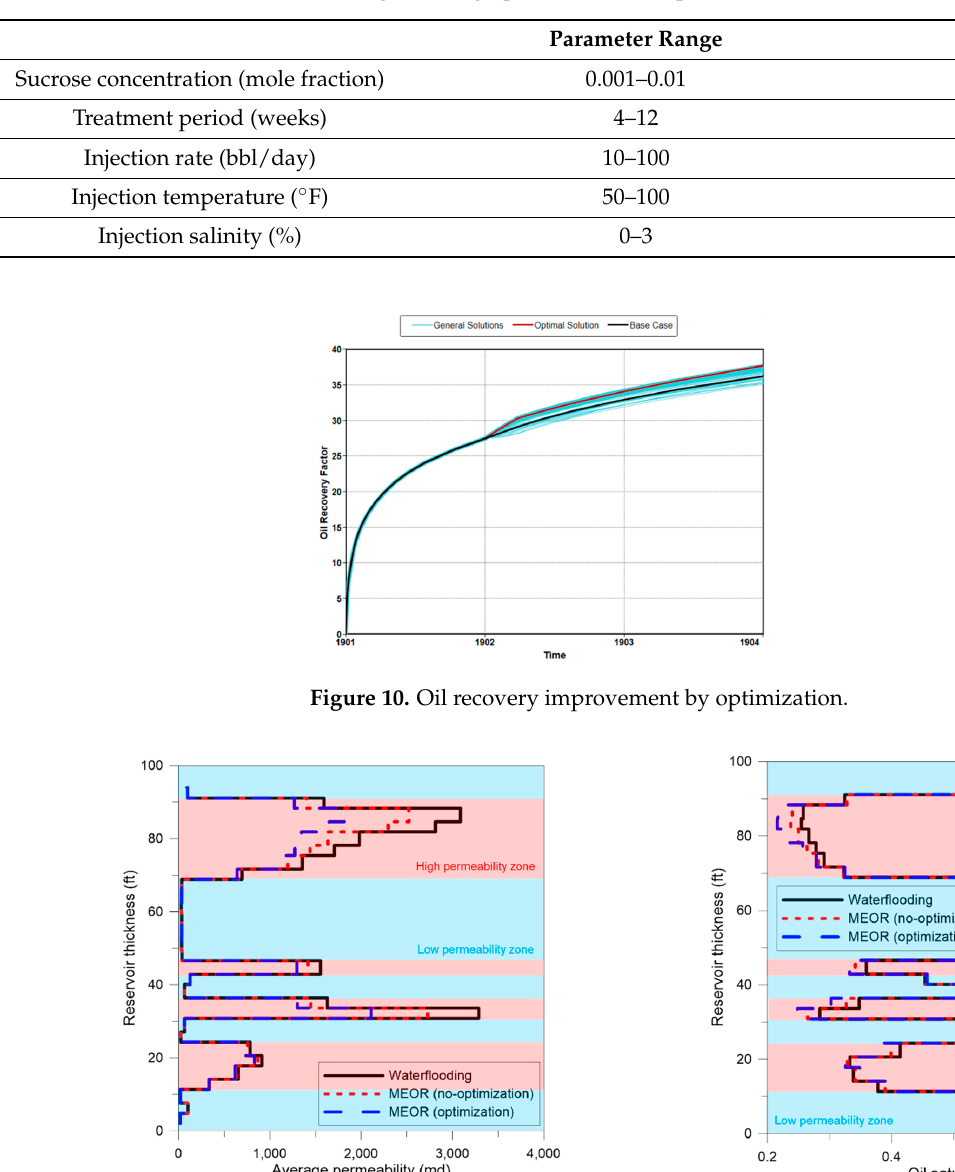
Table 4. Range of design parameters and optimization results for actual field.